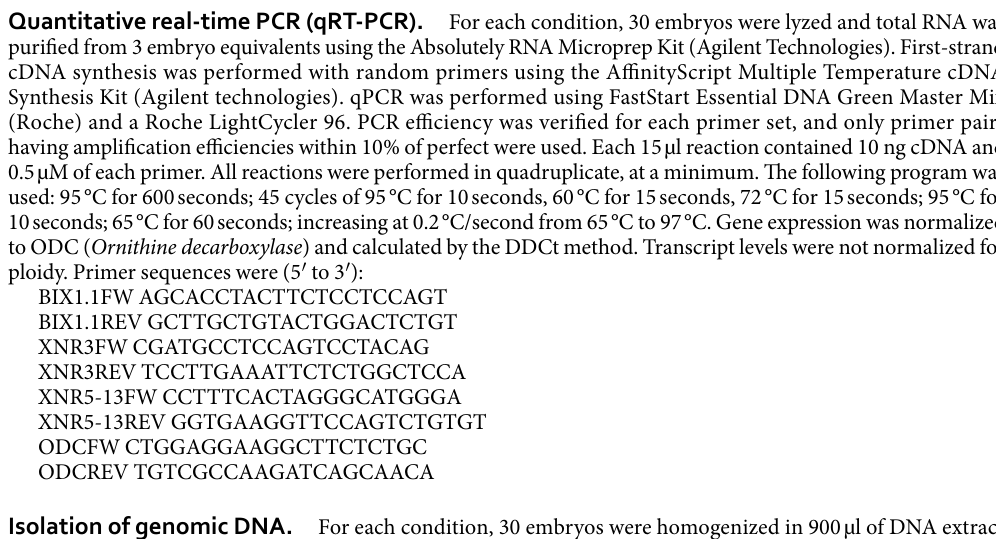
Quantitative real-time PCR (qRT-PCR). For each condition, 30 embryos were lyzed and total RNA was purified from 3 embryo equivalents using the Absolutely RNA Microprep Kit (Agilent Technologies). First-strand cDNA synthesis was performed with random primers using the AffinityScript Multiple Temperature cDNA Synthesis Kit (Agilent technologies). qPCR was performed using FastStart Essential DNA Green Master Mix (Roche) and a Roche LightCycler 96. PCR efficiency was verified for each primer set, and only primer pairs having amplification efficiencies within 10% of perfect were used. Each 15 µ l reaction contained 10 ng cDNA and 0.5 µ M of each primer. All reactions were performed in quadruplicate, at a minimum. The following program was used: 95 °C for 600 seconds; 45 cycles of 95 °C for 10 seconds, 60 °C for 15 seconds, 72 °C for 15 seconds; 95 °C for 10 seconds; 65 °C for 60 seconds; increasing at 0.2 °C/second from 65 °C to 97 °C. Gene expression was normalized to ODC ( Ornithine decarboxylase ) and calculated by the DDCt method. Transcript levels were not normalized for ploidy. Primer sequences were (5 ′ to 3 ′ ):